Question: Draft a figure caption describing what is shown.
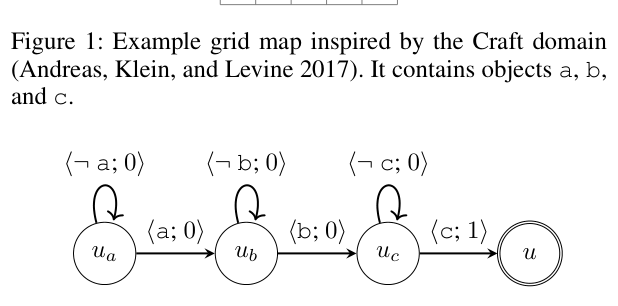
Answer: Boolean reward machine with Boolean features a, b, and c for a sequential task a-b-c.